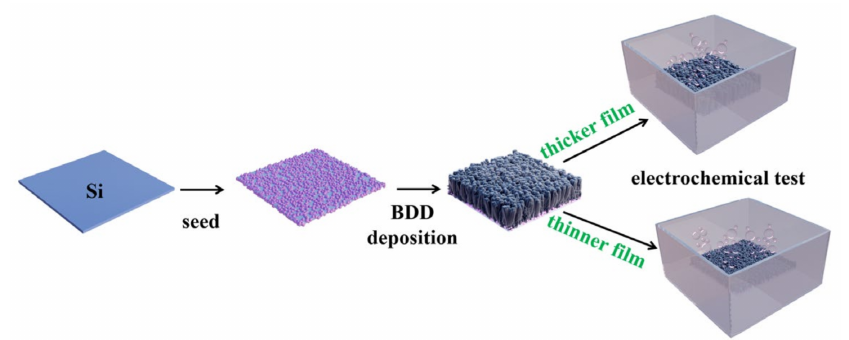
Figure 5. Schematic diagram of the BDD electrode preparation